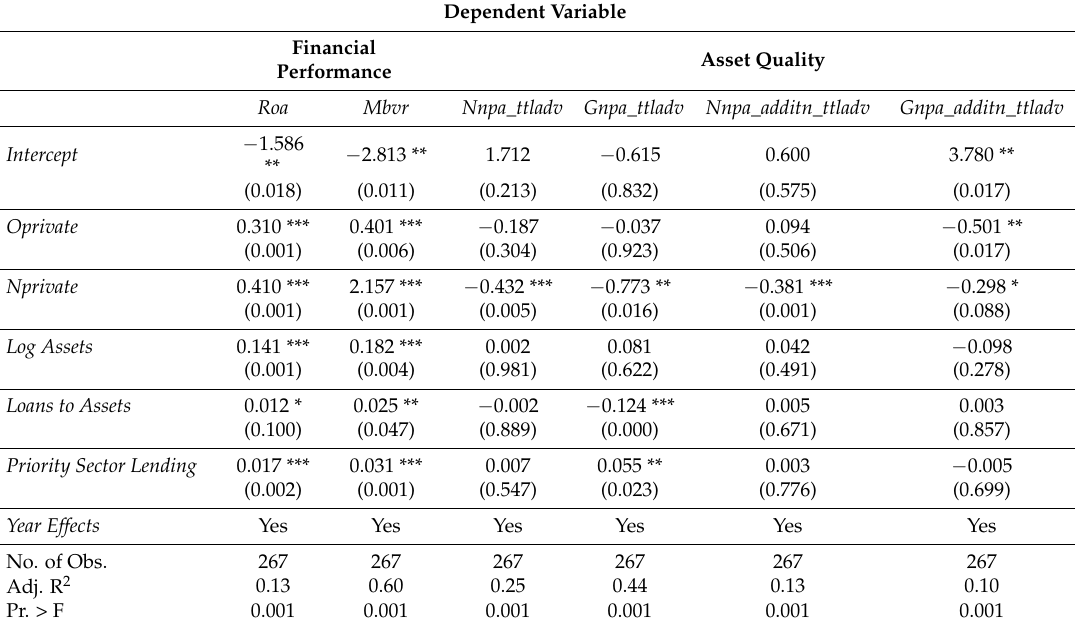
Table 3. Bank Ownership and